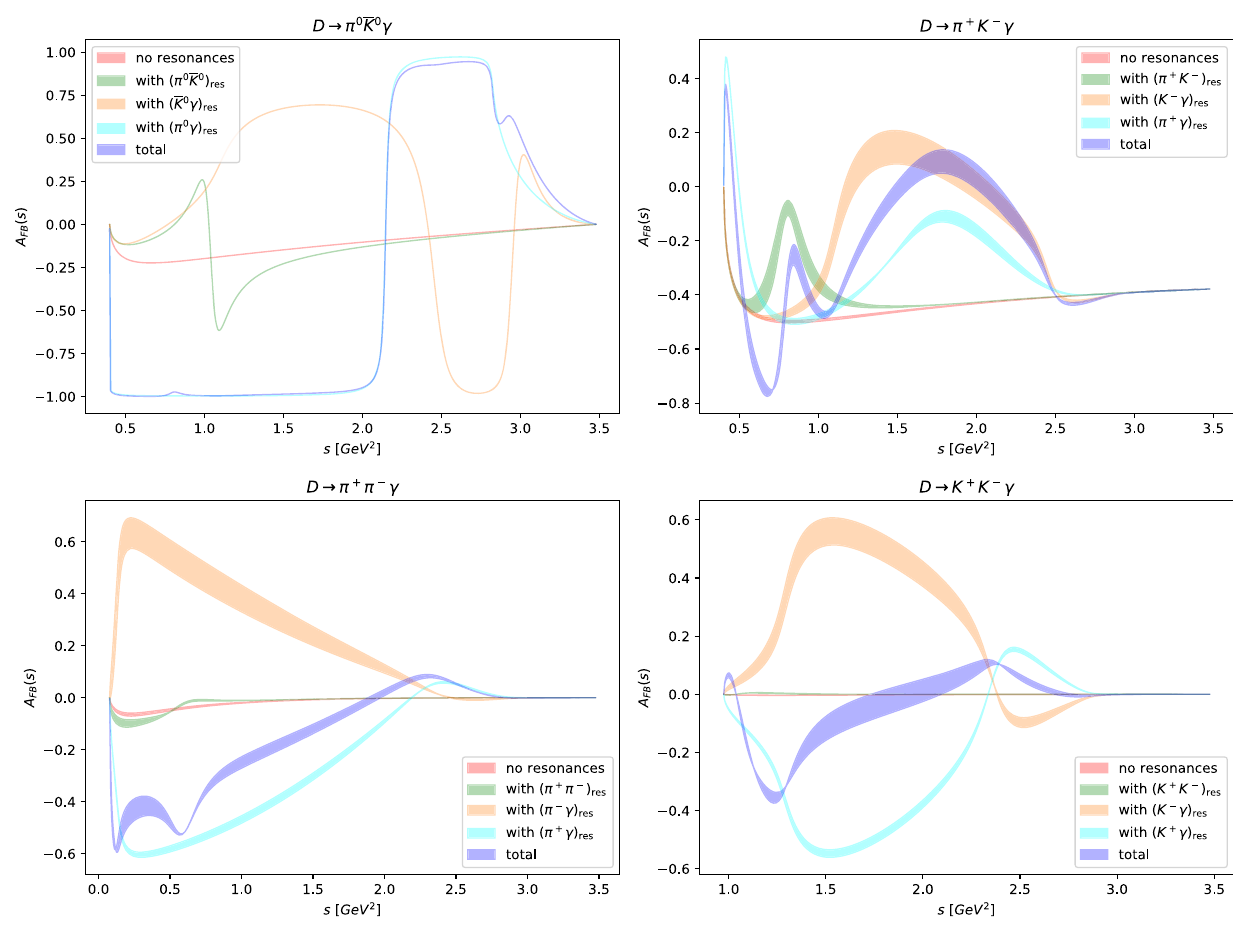
Fig. 4 The forward–backward asymmetry A FB ( s ) (32) as a function of s . The red bands contain only non-resonant contributions. The green, orange and light blue bands contain additional contributions of a spe-